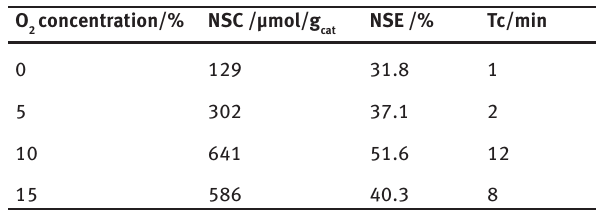
adsorption efficiency, NO Table 2: NO x NO ratio, breakthrough time and adsorption saturation time under x different oxygen concentration at 350